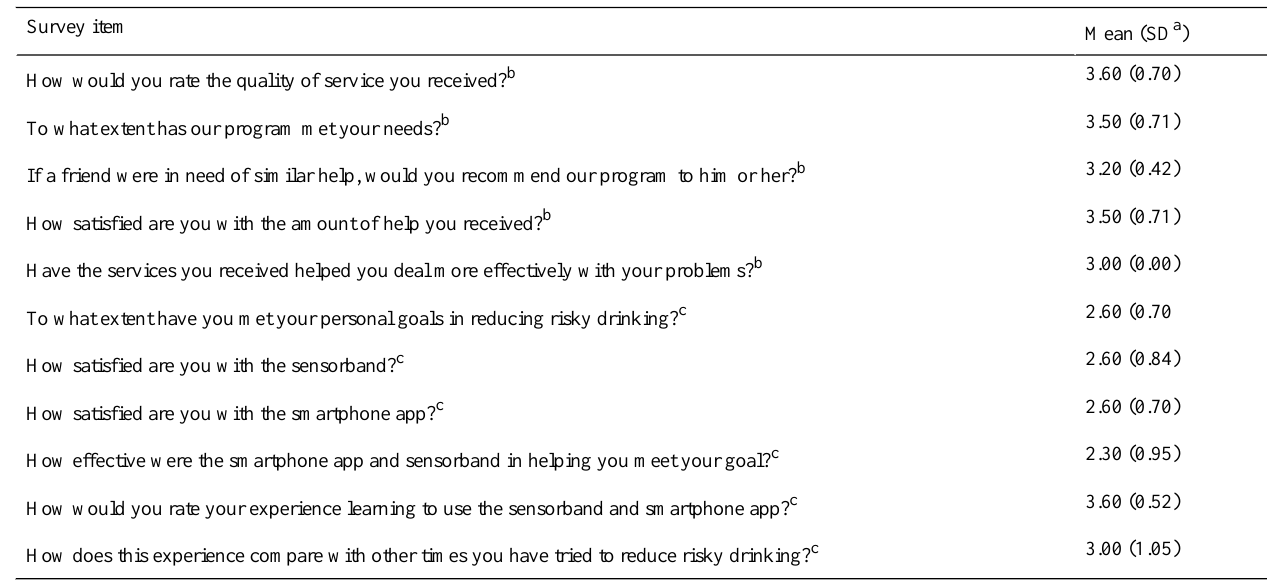
Table 2. Acceptability Questionnaire (n=10).